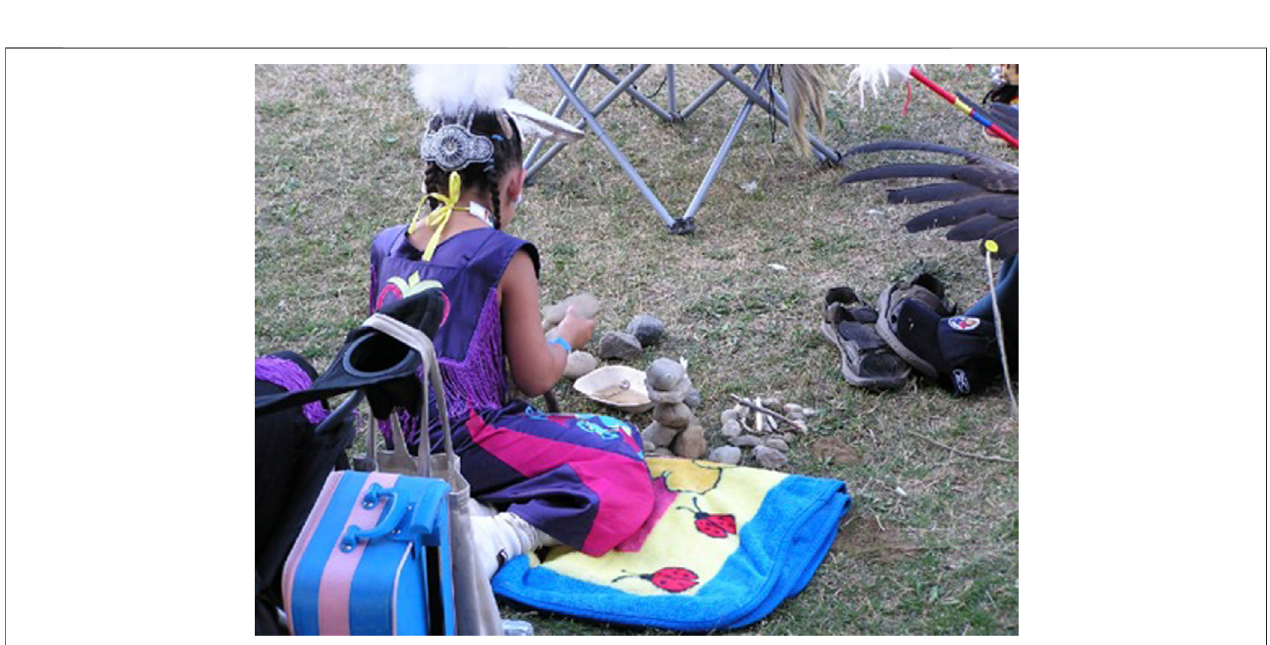
FIGURE 2 | Champion dancer waiting to be called to the powwow arena (photo credit: Sharla Peltier).